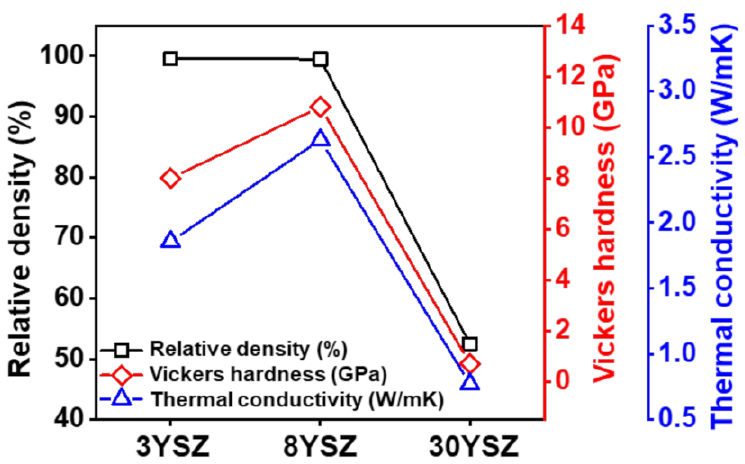
Figure 7. Relative density, Vickers hardness, and thermal conductivity of the sintered YSZ bodies with various Y 2 O 3